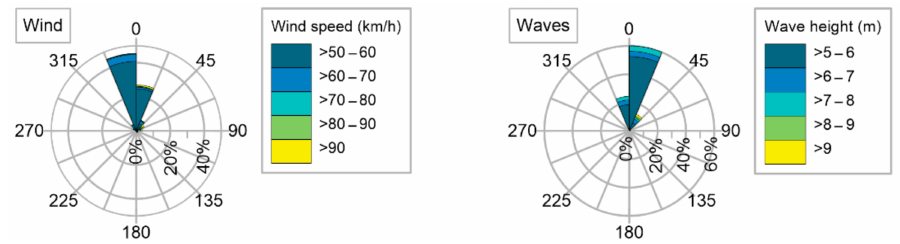
Figure 6. Annual wind and wave roses for extreme events for La Mancha, data from [26]. Tides